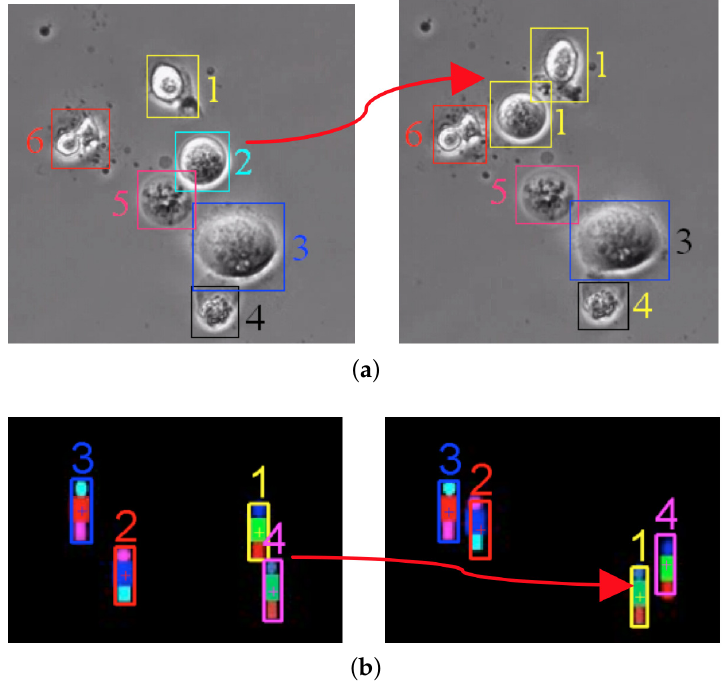
Figure 1. Tracking targets in close movement with the conventional Gaussian mixture probability hypothesis density (GM-PHD) tracker. ( a ) Mistracking two cells (Cells 1 and 2 in the left image) with the same identity (Cell 1 in the right image); ( b ) mistracking two targets (Targets 1 and 4 in the left image) with switched identities (Targets 4 and 1 in the right